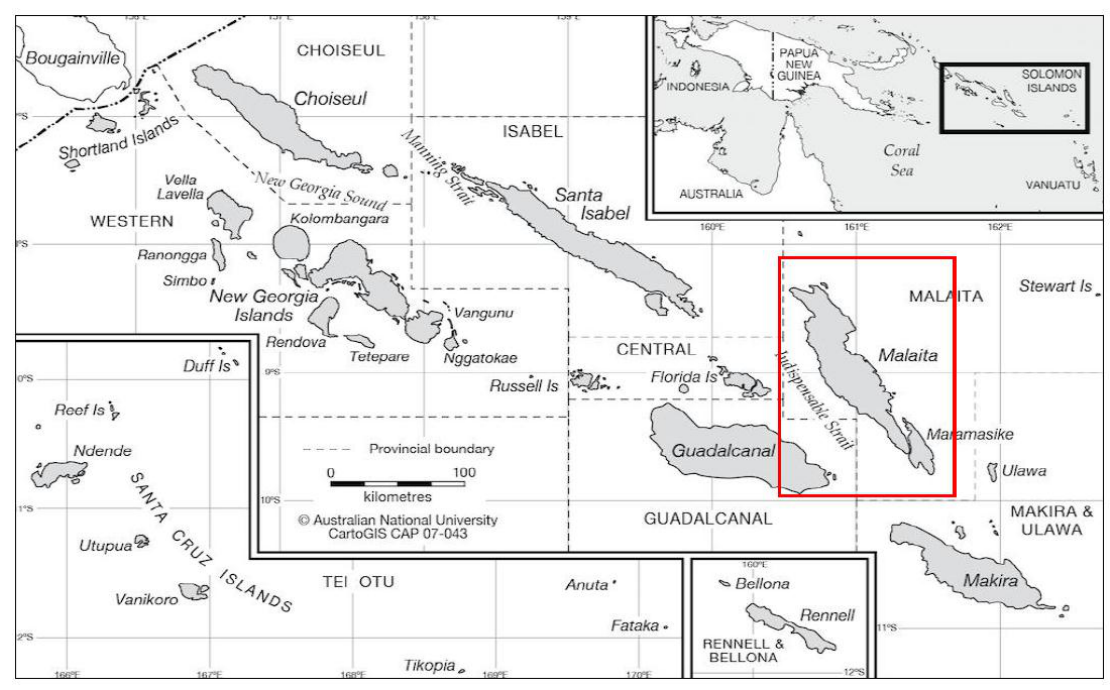
Figure 1. Map of the Solomon Islands. Location of Malaita Island (indicated in the red box) within the Solomon Islands archipelago (Map source: CartoGIS Services, College of Asia and the Pacific, The Australian National University, Australia, 2018) [21].